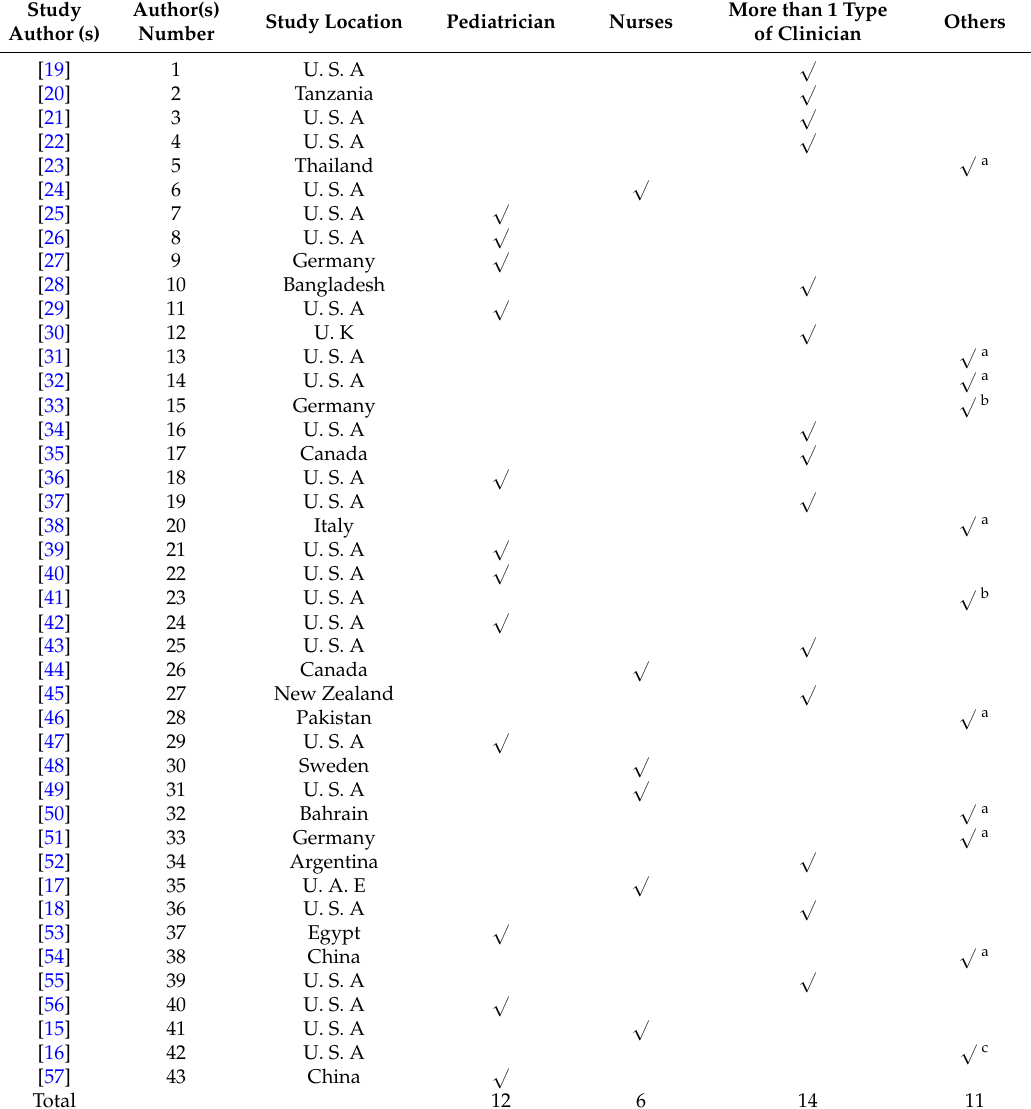
Table 1. Showing study characteristics and type(s) of clinicians